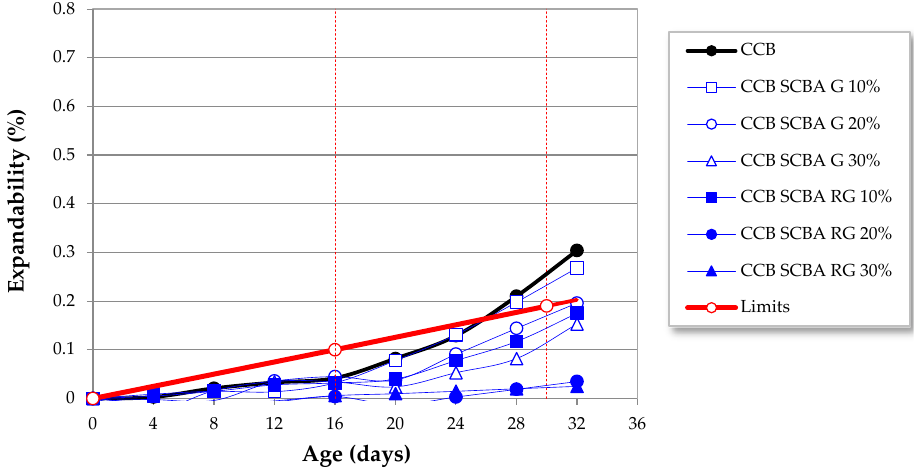
Buildings 2023 , 13 , x FOR PEER REVIEW Figure 17. Comparison between the expandability of mortars developed with basalt aggregates. Flexural strength mortars with reactive aggregates before the ASR test is shown in Figure 18. The flexural tensile strength for mortars 900 days after the ASR expandability test is shown in Figure 19. You can see that the mortars with SCBA RG maintained higher levels of tensile strength in flexion after the alkalis attack. In general, the SCBA thermal treatment improvement improves the performance of mortars in several aspects, as re- ported in the literature [30], including mechanically and in the inhibition of expansions caused by ASR.